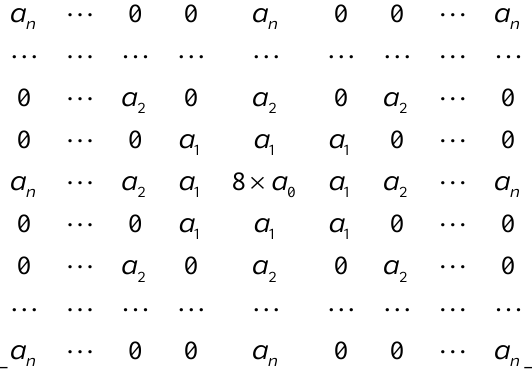
Figure 3. The (2𝑛 + 1) × (2𝑛 + 1) fractional differential operators in 8 directions.